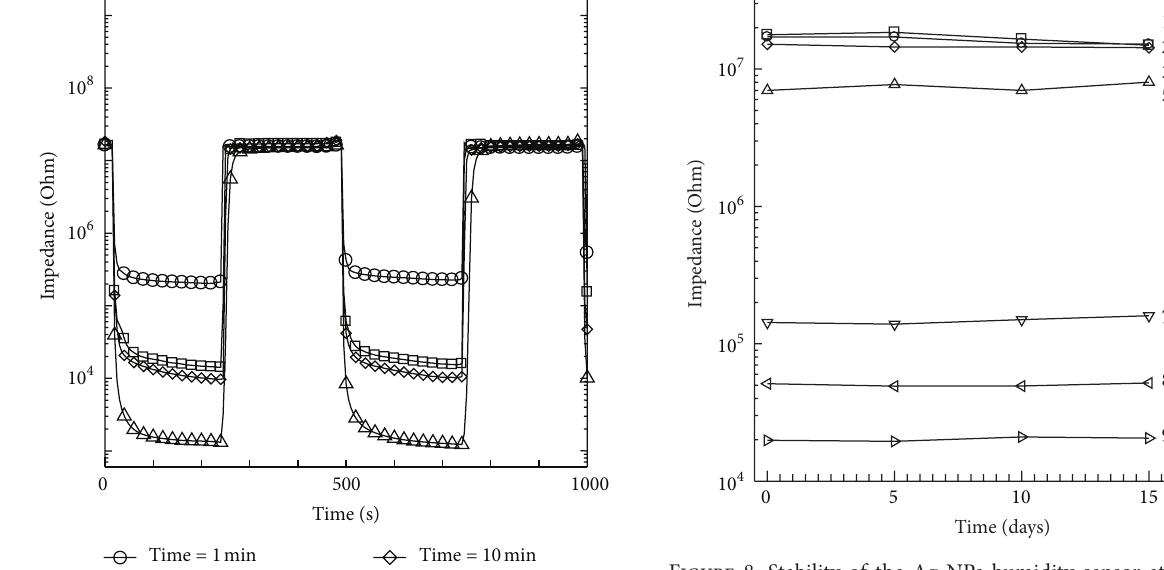
Figure 8: Stability of the Ag NPs humidity sensor at deposition times of 5 min after being kept at the ambient